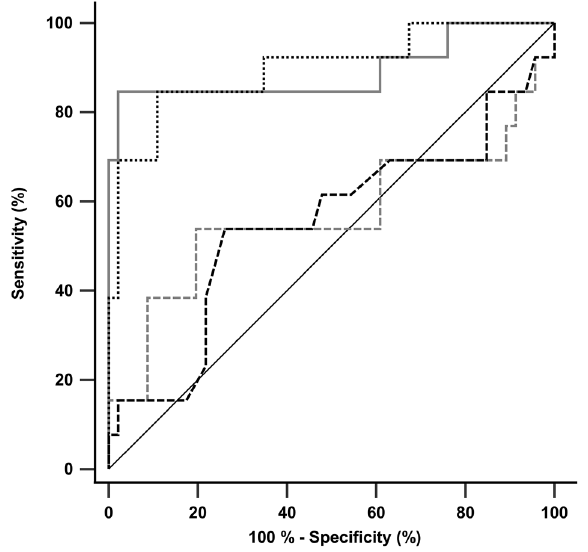
Figure 3. Receiver operating characteristic (ROC) curves of the acute stage diffusion measures for identification of animals dying prematurely. ROC curves of lesion volume during occlusion (dashed gray line), lesion volume at reperfusion (solid gray line), mean ADC of the initial lesion site during occlusion (dashed black line) and mean ADC of the initial lesion site at reperfusion (dotted black line) are